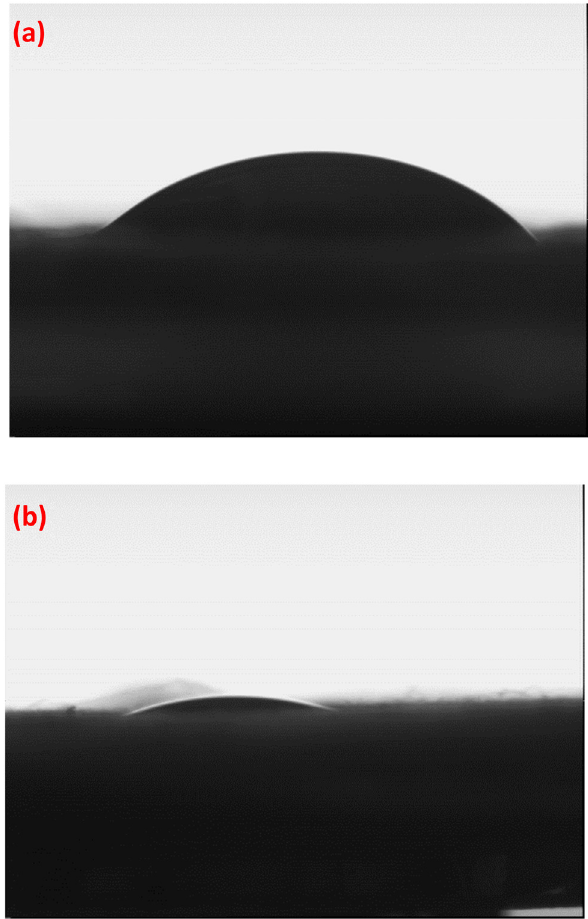
Figure 10: Representative pro fi les of motor oil ( SAE 15W - 50 synthetic Motor Oil ) droplets on electrospun THV fi bers prepared from the following solutions: ( a ) sample 4: THV/ethyl acetate 15 wt%: 15 cm_11 gauge_19 kV. ( b ) Sample 2: THV/acetone 15 wt%: 15 cm_22 gauge_16 kV ( b ) . Contact angle is ( a ) 42.6° and ( b ) less than